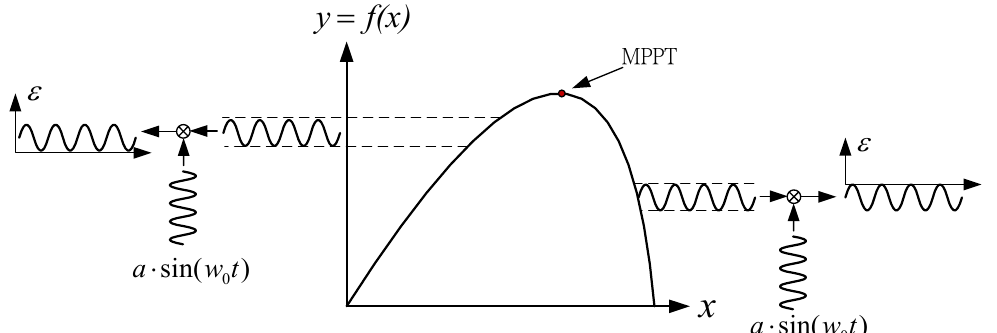
Figure 10. An illustration of a sinusoidal